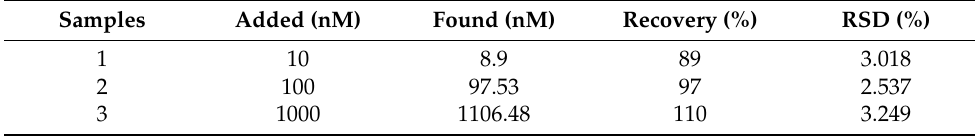
Figure S4: The effect on the fluorescence of DNA modified with Green I in different concentra-tions of GO, Figure S5: Detection of Hg 2+ using physical adsorption of DNA, Figure S6: The fluorescence intensity of FAM-modified GO-DNA probe at different